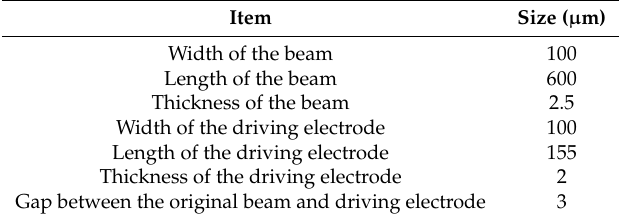
Table 2. Geometric parameters of the spring-like double-clamped beam